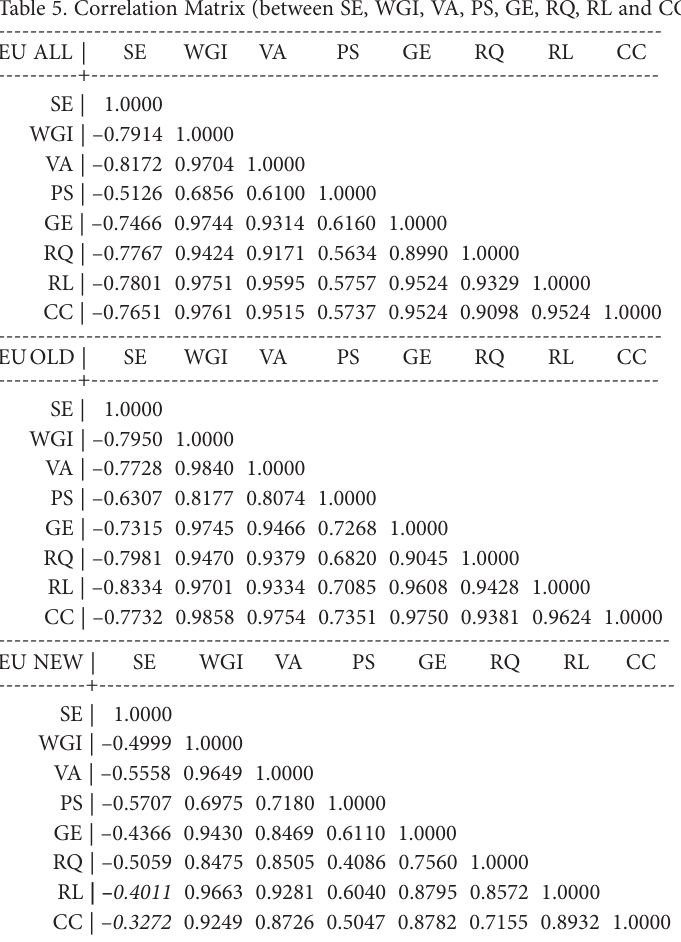
Table 5. Correlation Matrix (between SE, WGI, VA, PS, GE, RQ, RL and CC) ----------------------------------------------------------------------------------- EU ALL | SE WGI VA PS GE RQ